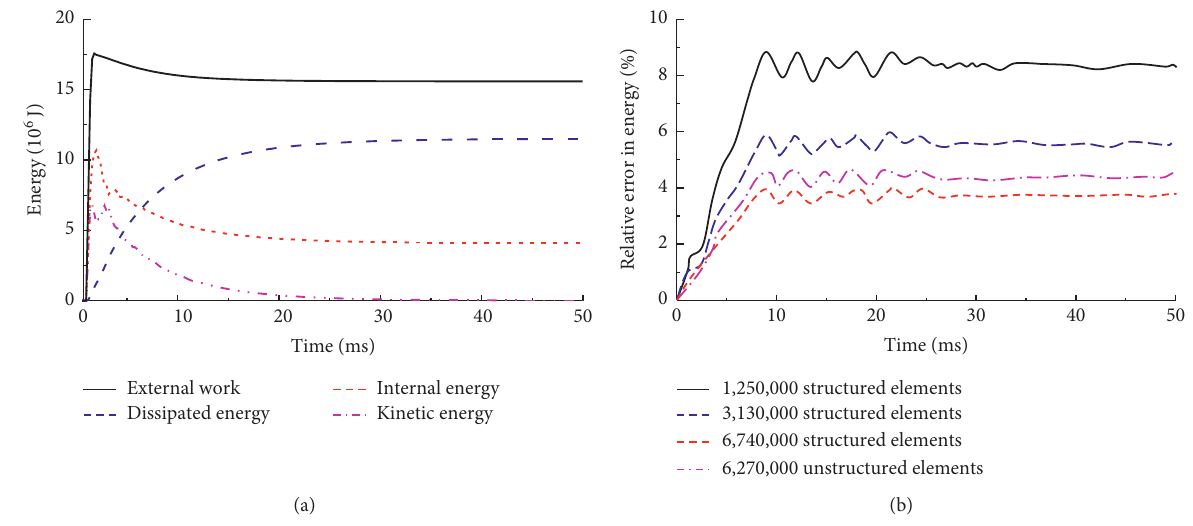
Figure 14: Time histories of (a) energy and (b) relative errors in the energy